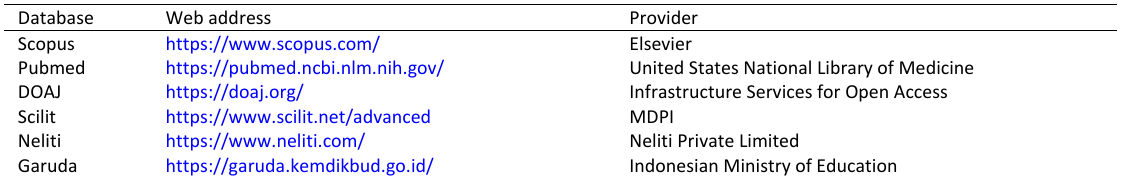
Table 1: Detail of the databases